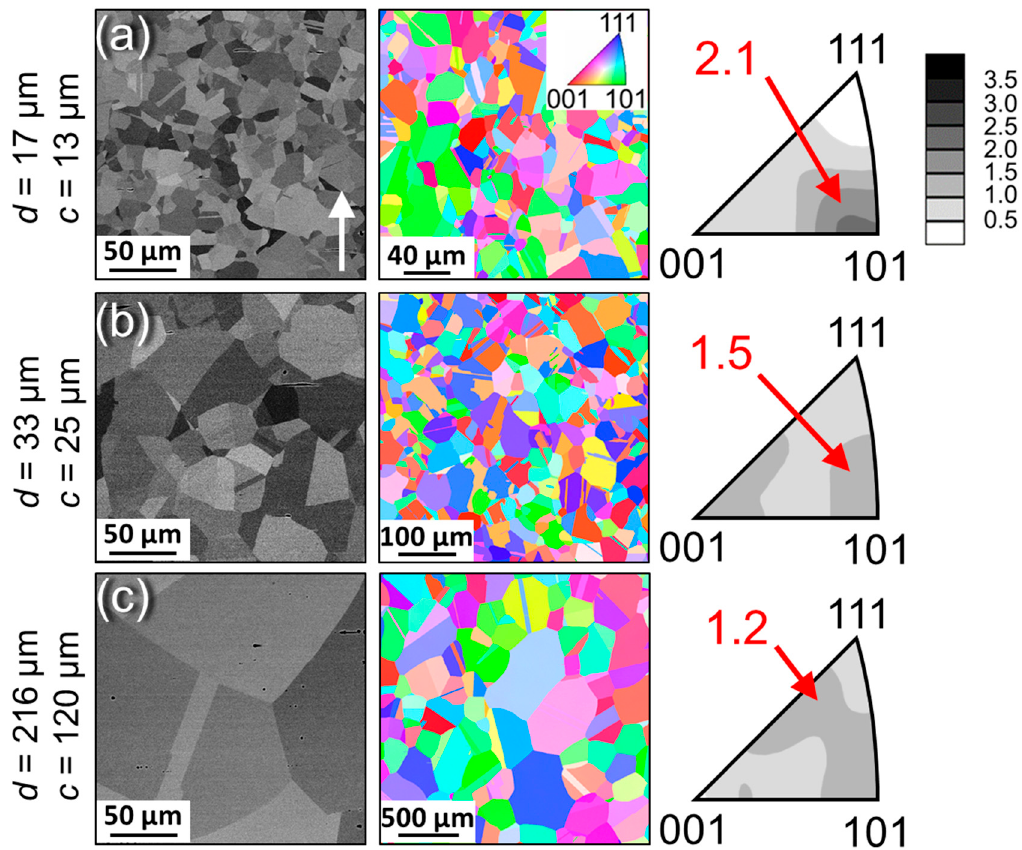
Figure 4. Representative microstructures of recrystallized MnFeNi with different grain and crystallite sizes: ( a ) d = 17 µ m, c = 13 µ m, ( b ) d = 33 µ m, c = 25 µ m, ( c ) d = 216 µ m, c = 120 µ m. Figures in the first column are BSE micrographs, those in the second are color ‐ coded crystallite orientation maps, see colored stereographic triangle in the second column of ( a ) for color decoding. Figures in the third column are inverse pole figures (IPFs) showing the texture along the longitudinal axis of the compression specimens.